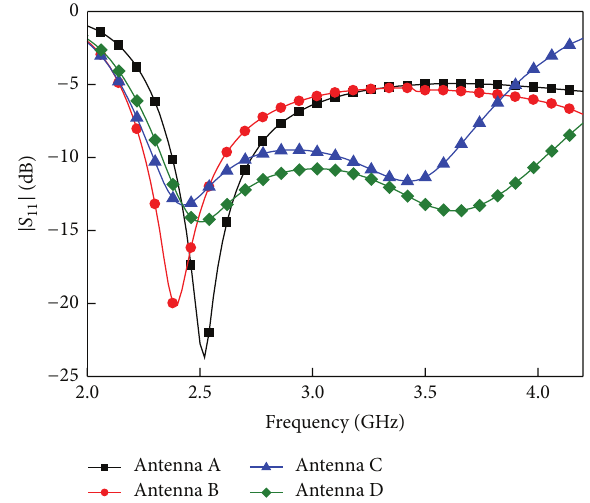
Figure 3: Simulated | S11 | performances of the